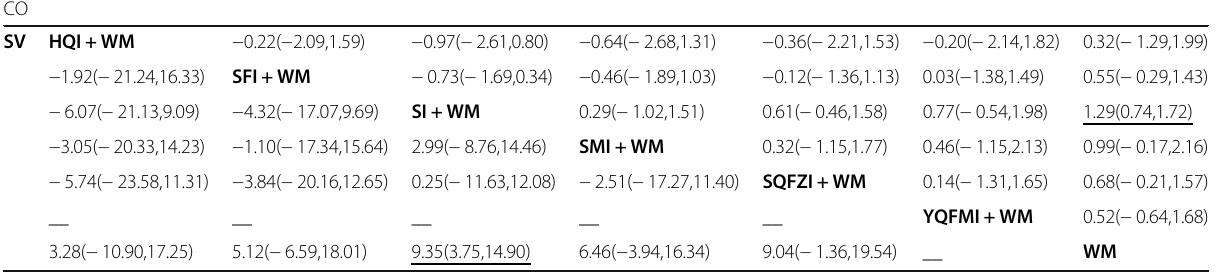
Table 2 Mean difference (95%CIs) of CO (right upper part) and SV (left lower part) CO